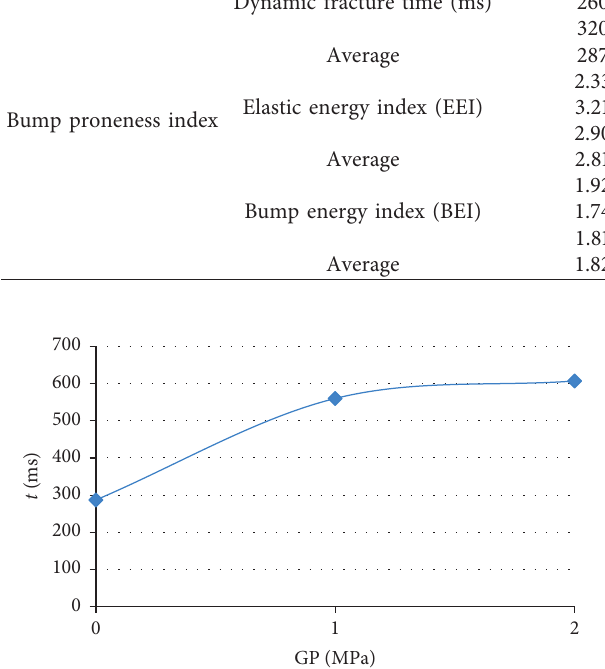
Figure 22: Variation in elastic energy index with changing gas